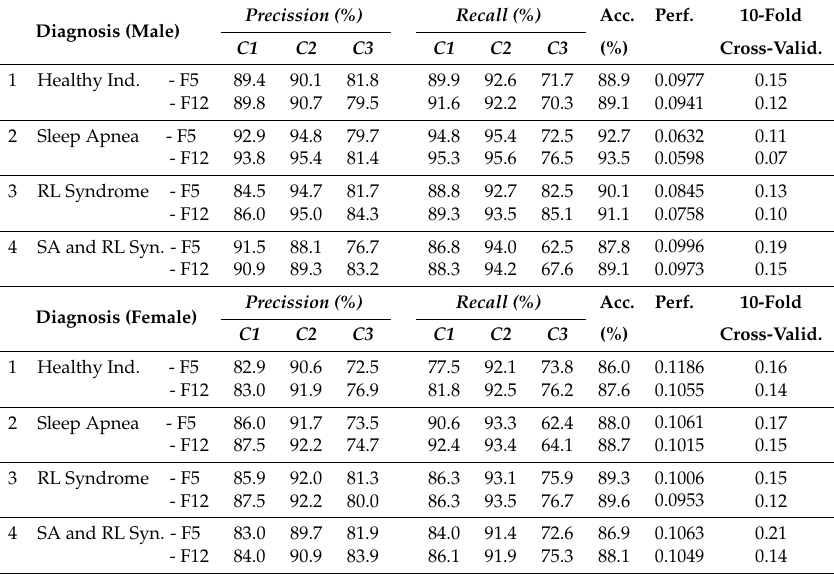
Table 6. Evaluation of sleep stage classification (Classes: C 1—Wake, C 2—NonREM, C 3—REM) of sets of (i) healthy individuals; (ii) individuals with sleep apnea (SA); (iii) individuals with the restless leg (RL) syndrome, and (iv) individuals with sleep apnea and RL syndrome using the single EEG channel for 5 (F5) mean EEG power features (in bands 1–4, 4–8, 8–12, 12–16, and 16–20 Hz), and 12 (F12) features with additional 4 features evaluated from the flow channel (for frequency bands 0.05–0.2, 0.2–0.3, 0.3–0.4, 0.4–0.8 Hz) and 3 features related to the electro-oculogram channels (4–15, 15–30, 30–40